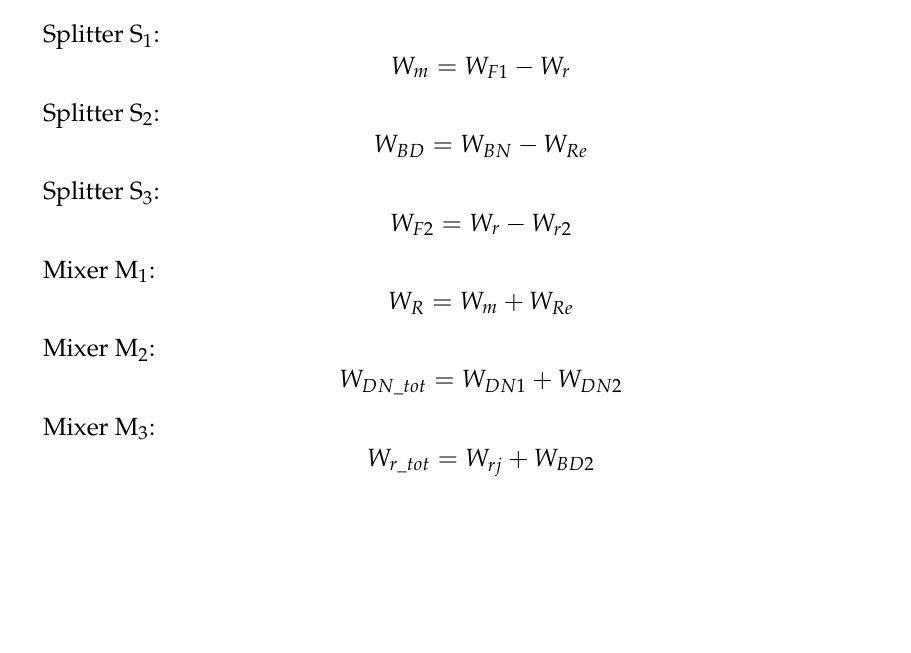
Figure 5. Option 5 — the rejected water of BR-MSF system as the feed water of the SWRO system. Figure 5. Option 5—the rejected water of BR-MSF system as the feed water of the SWRO